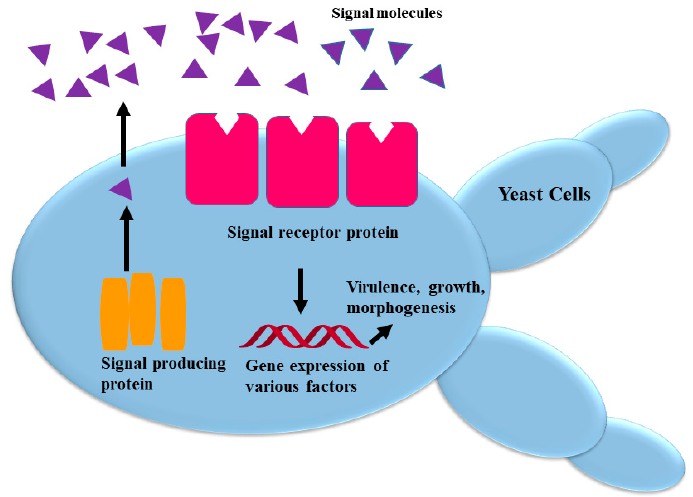
Figure 1. Quorum-sensing mechanism in Fungi (adapted from [3]). Signal molecules are synthesized from signal-producing proteins which are detected by signal-receptor proteins and stimulate various genes expression.